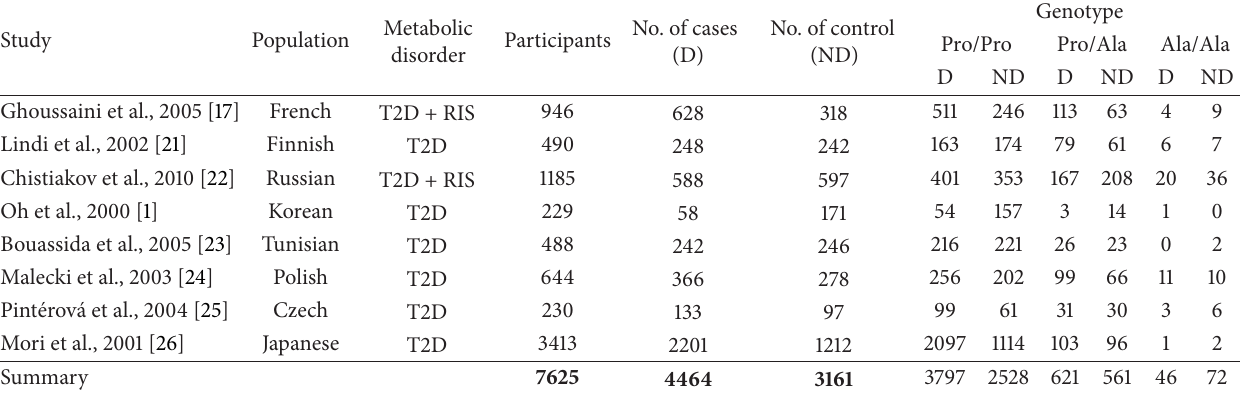
Table 2: Included studies in the meta-analysis for T2D and respective genotype of the studied population.